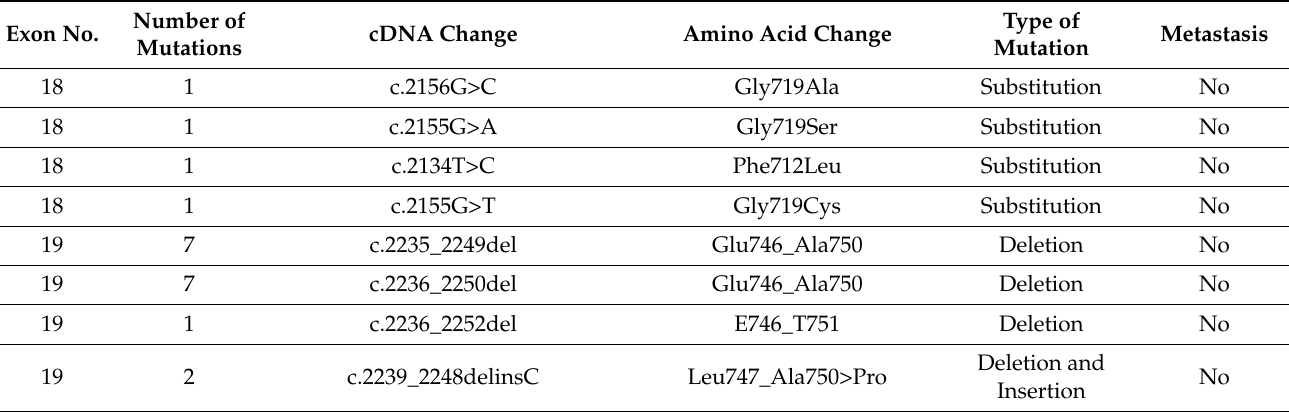
Table 3. Types of most common EGFR mutations, exon locations, and metastatic